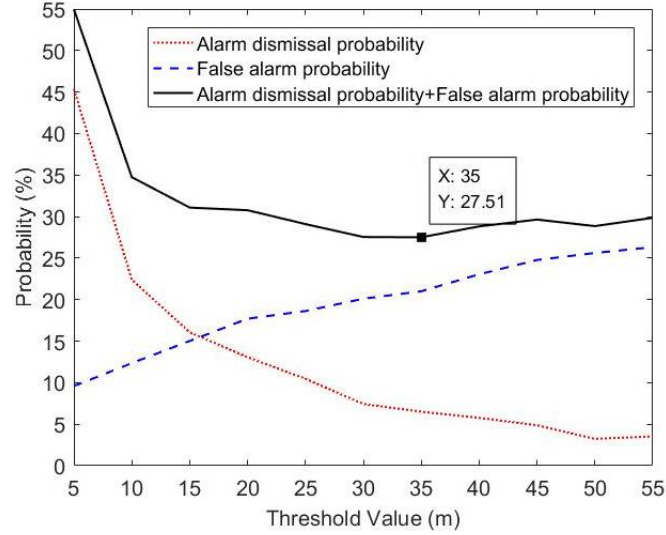
Figure 4. Effect of identification threshold on false alarm probability and alarm dismissal probability.